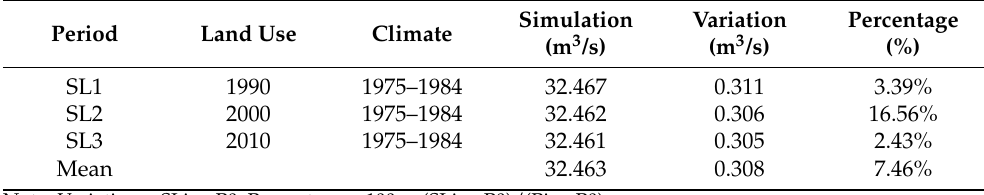
Table 6. Contribution of land use change to surface runoff